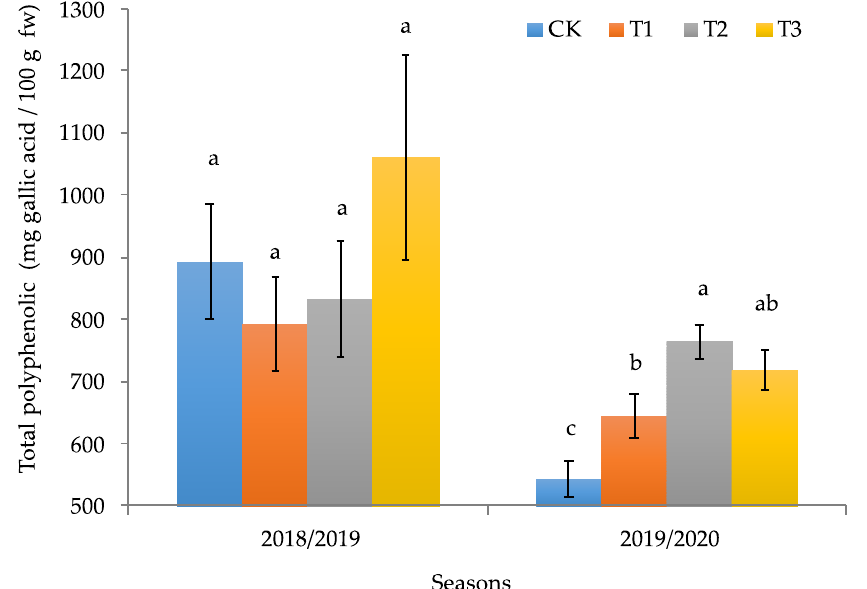
Figure 6. Effect of different doses of compost on the total polyphenolic content of calafate fruit ( Berberis mycrophilla G. Forst) for the 2018–2019 and 2019–2020 seasons. CK = Control treatment (without compost application); T1 = Treatment 1 (5 Ton ha − 1 ); T2 = Treatment 2 (10 Ton ha − 1 ); T3 = Treatment 3 (15 Ton ha − 1 ). For each treatment, different lowercase letters indicate significant differences in both seasons according to Fischer’s LSD test ( p < 0.05). The bars correspond to the experimental error of each